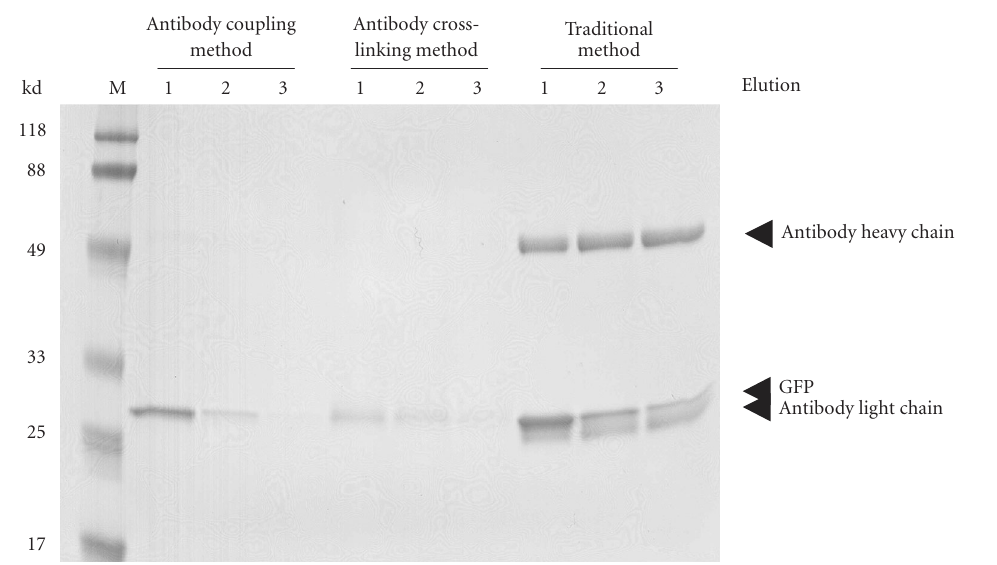
Figure 5. Comparison of IP using antibody cross-linked protein G agarose, antibody-coupled agarose, and non-cross-linked antibody with protein G agarose. In each case, 130 µ g of a ffi nity-purified goat anti-GFP antibody was used with 100- µ L of settled protein G gel or coupling gel. IP was performed using 135 µ g of partially purified GFP. Ten percent of the elution volume was electrophoresed on a 12% polyacrylamide reducing gel and stained with Coomassie. Lane M, BlueRanger molecular weight marker; lanes 1–3 elutions from di ff erent antibody immobilization